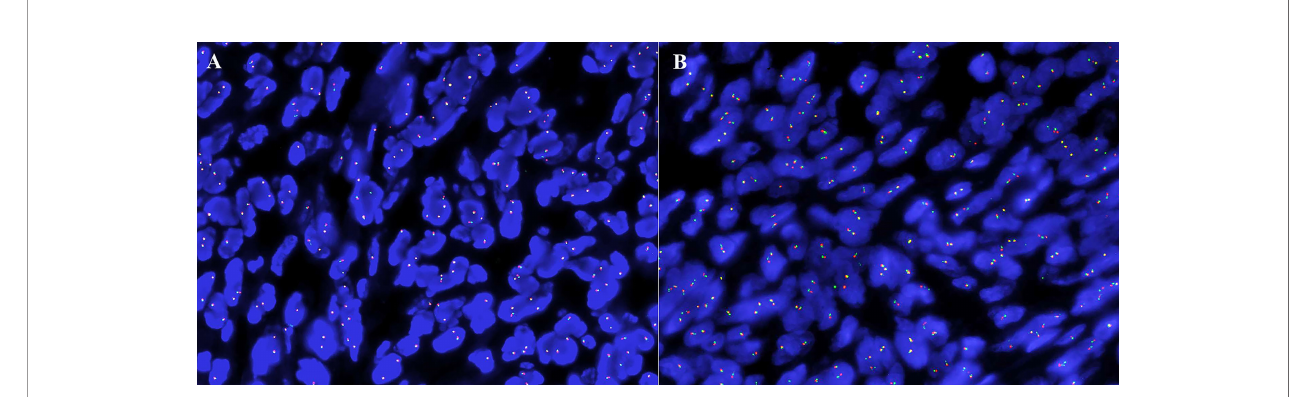
FIGURE 4 | The absence of CSF1 (A) and USP6 (B) translocation in fl uorescence in situ